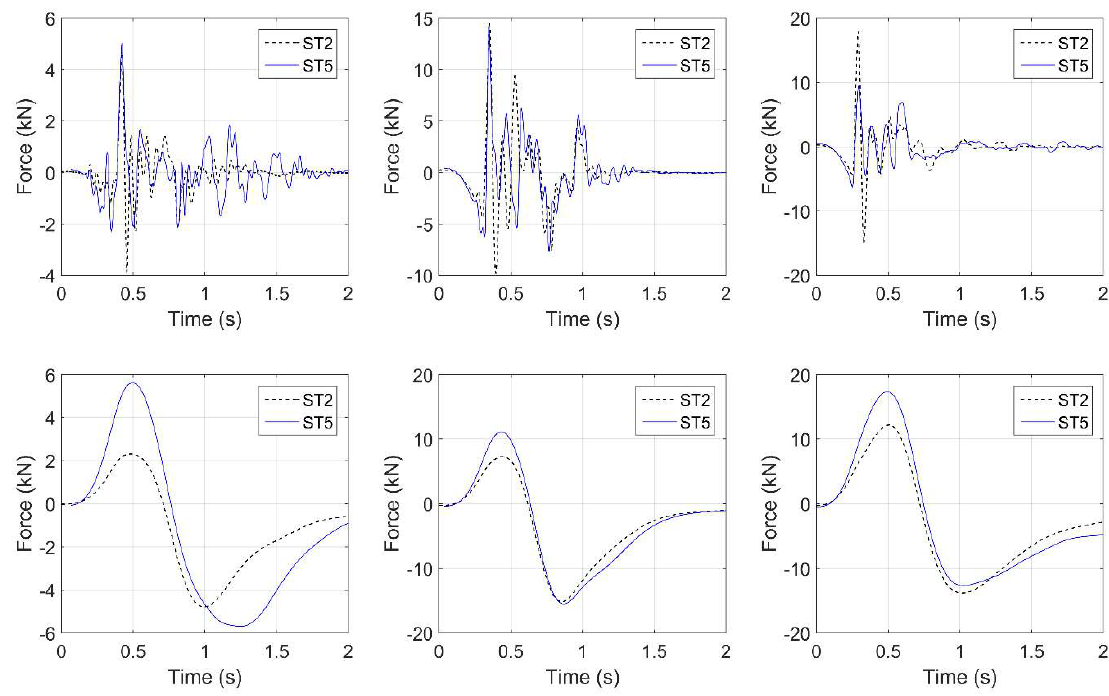
Figure 13. Time-histories of slamming and quasi-static total vertical forces, for two deck types and two waves with H = 0.42 m, H = 0.55 m, and H = 0.90 m Table 4. Ratios of maximum total uplift forces of the deck with solid diaphragms (ST5) to the maximum values of the deck with cross-frames (ST2).